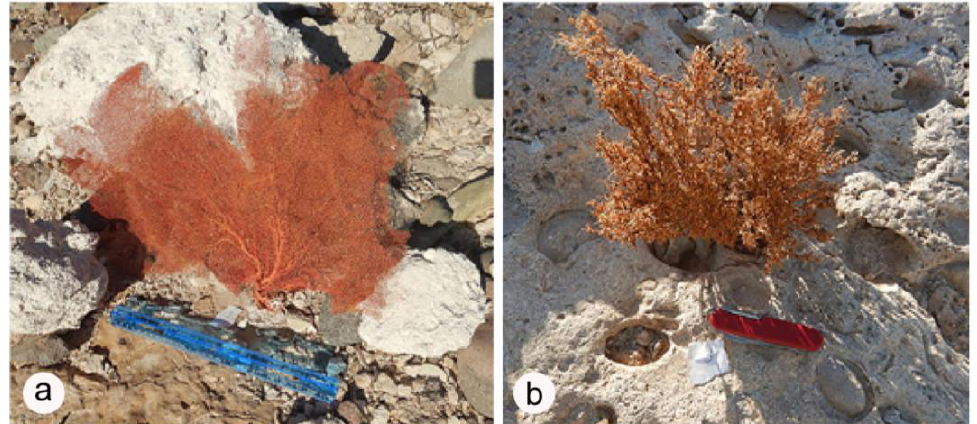
Figure 4. Evidence for biological disruptions observed on the 12 m limestone terrace at Arroyo Blanco from the east coast of Isla del Carmen: ( a ) Displaced sea fan ( Pacifigorgia adamsi) sitting upright against rocks on the rock platform at locality 1 on the map in Figure 2 (12-inch ruler for scale = 30 cm); ( b ) Completely desiccated land plant identified as the Gulf Star Violet ( Stenotis mucronate ) grew in place on the rock platform at locality 3 on the map in Figure 2 (pocket knife for scale = 9 cm). Table 1. Sea fans ( Pacifigorgia adamsi ) detached from the seabed and deposited on the 12 m limestone terrace at Arroyo Blanco on the eastern coast of Isla del Carmen during Hurricane Kay in September 2022. Distance to Edge Elevation Above Mean Sea Specimen Number of the Terrace (m) Level